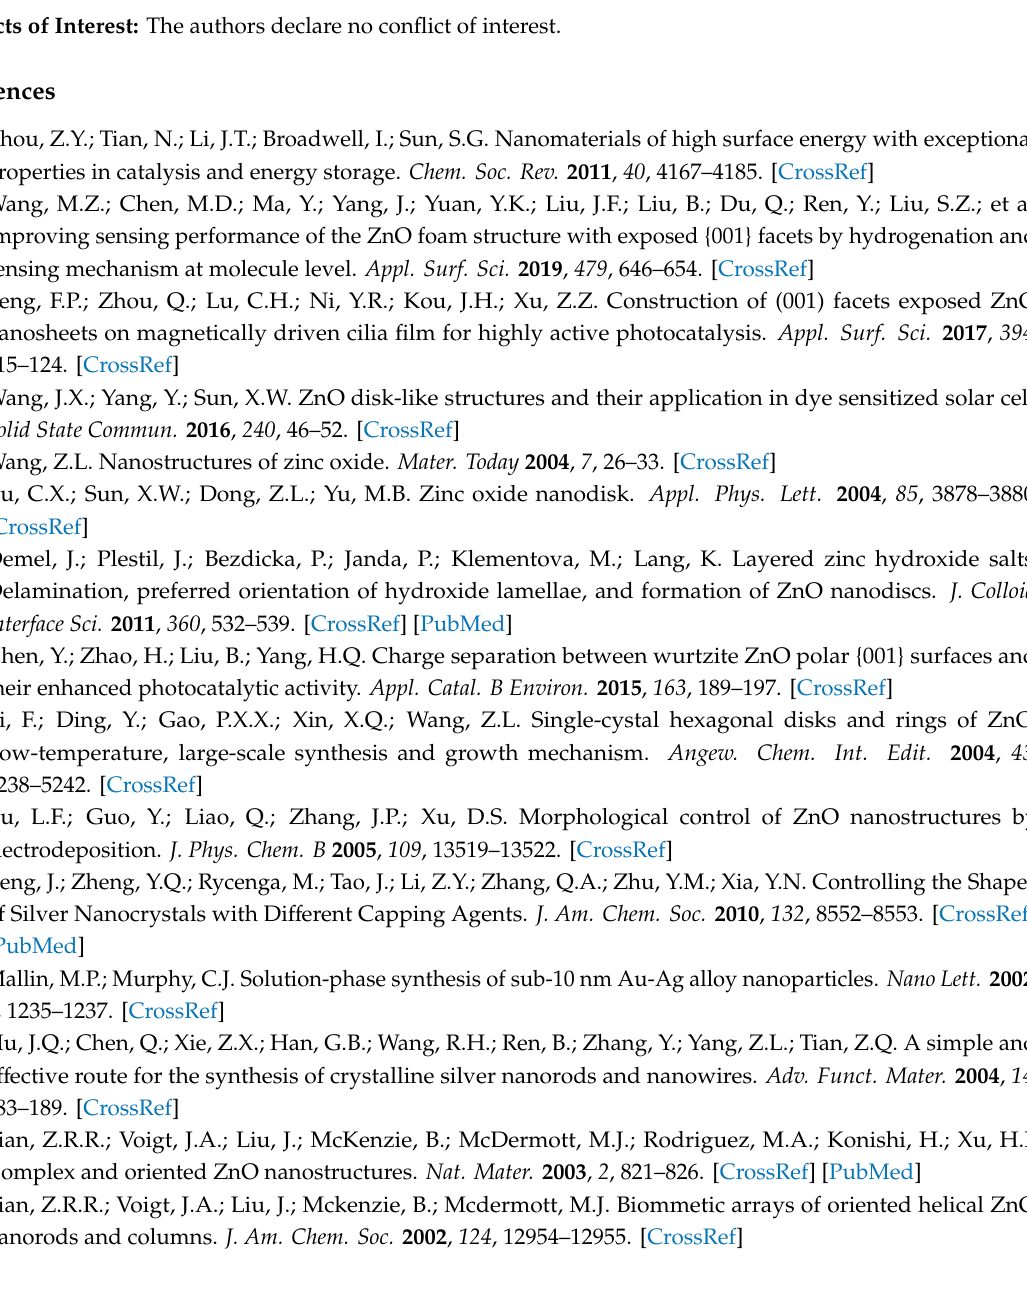
Figure S1: Distribution of Zn 2 + -OH − -H 2 O system, Figure S2: SEM image of ZnO nanorods, Table S1: Equilibrium equation and complex constant for Zn 2 + -C 6 H 5 O 73 − -H 2 O system (25 ◦